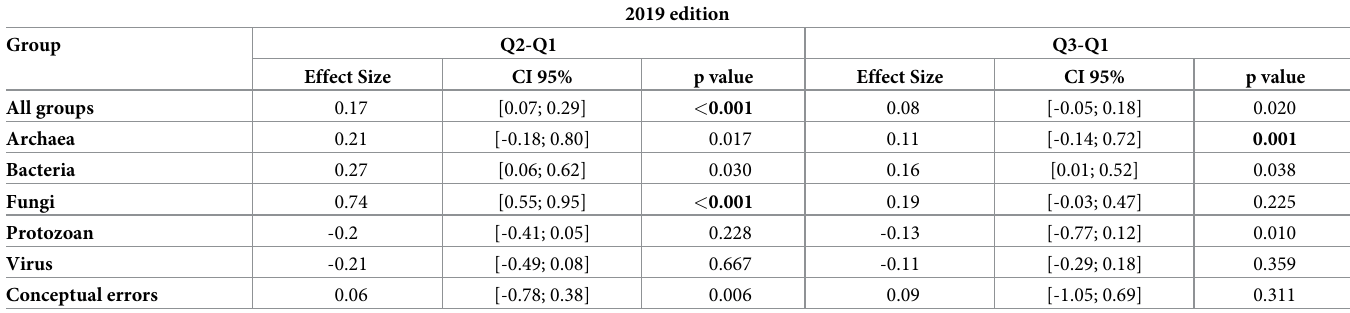
Table 1. Differences in the Shannon index between the questionnaires Q1 and Q2, and Q1 and Q3 for the 2019